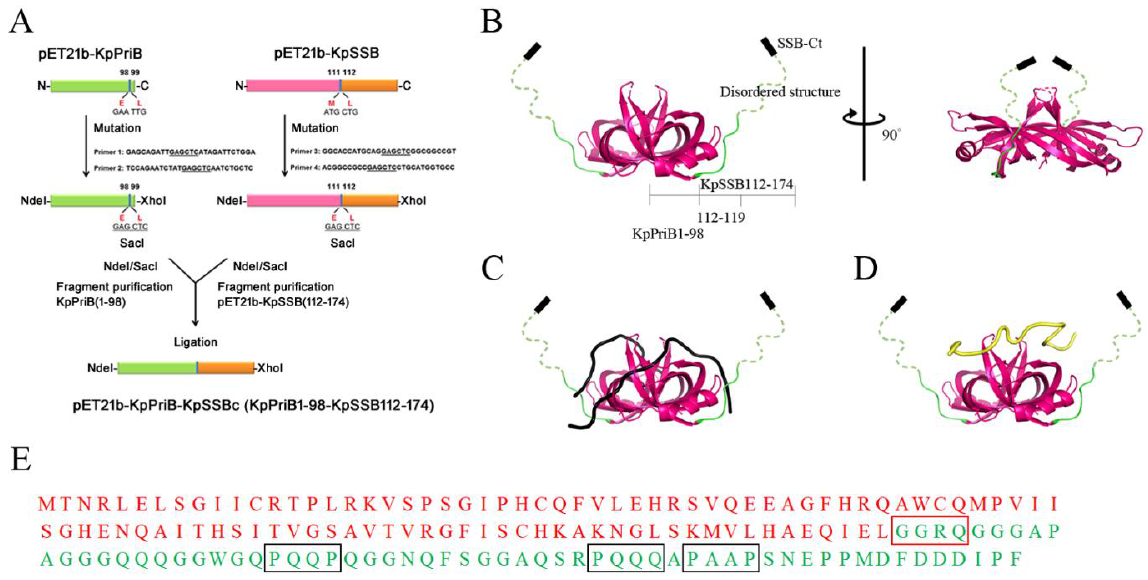
Figure 3. The chimeric PriB-SSBc protein. ( A ) Construction of the plasmid for expression of the chimeric PriB-SSBc protein. The resultant plasmid pET21b-KpPriB-KpSSBc will express KpPriB1–98 fused KpSSB112–174, designated as PriB-SSBc. Note that PriB-SSBc has 161 amino acid residues and does not have any artificial residues. ( B ) A proposed structure of PriB-SSBc. The structure was directly constructed by superimposing the KpPriB dimeric form (aa 1–98; PDB entry 4APV) with the crystal structure of KpSSB (aa 112–119; PDB entry 7F2N). The unobserved region (aa 120–174) in KpSSBc was shown as dashed lines. The ssDNA-binding property of PriB-SSBc may resemble that of ( C ) EcSSB or ( D ) EcPriB. ( E ) The putative amino acid sequence of